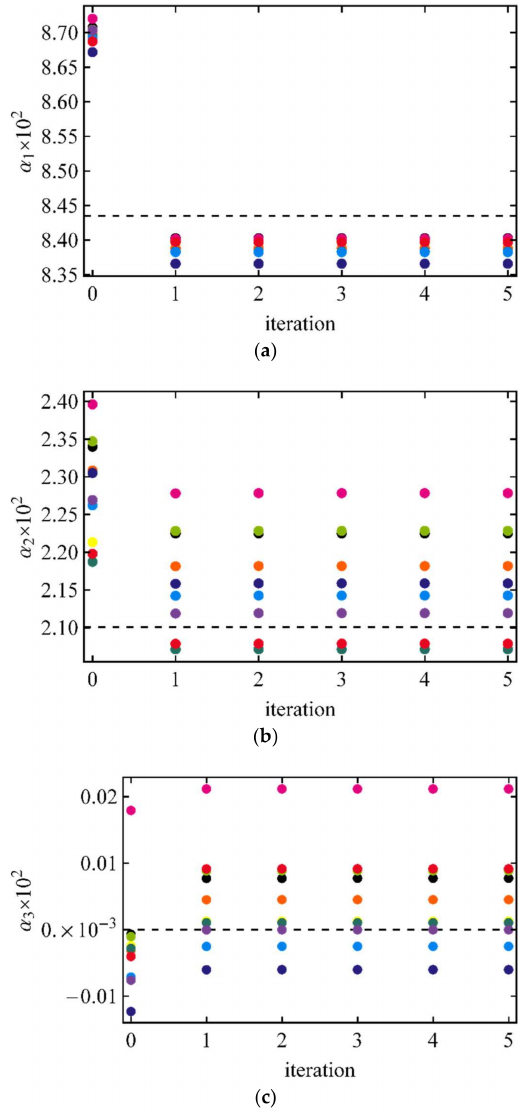
Figure 3. Convergence of coefficients α l ( × 100) in the case of BRDF (Equation (14)) with τ R = 0.1, τ R = 0.5. Different colors are 10 random realizations of 60 observations. Dashed lines—theoretical values. ( a ) α 1 ; ( b ) α 2 ; ( c ) α 3